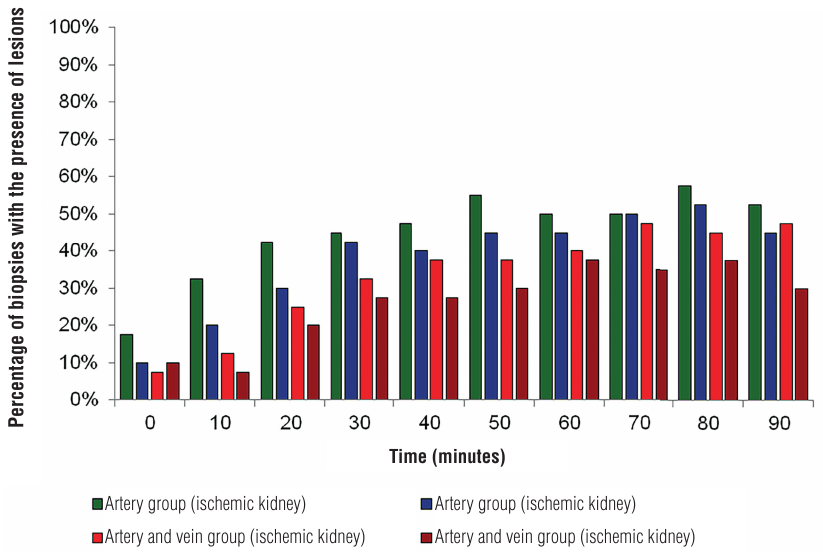
Figure 3 - Distribution of the proportion of biopsies with presence of